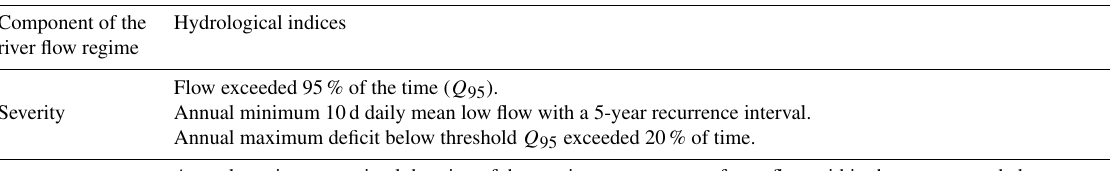
Figure 10. Results of the hierarchical cluster analysis applied to the climate response surface WR ∗ -level anomalies (cid:49) WR ∗ . Table 6. Hydrological metrics considered to investigate similarity in